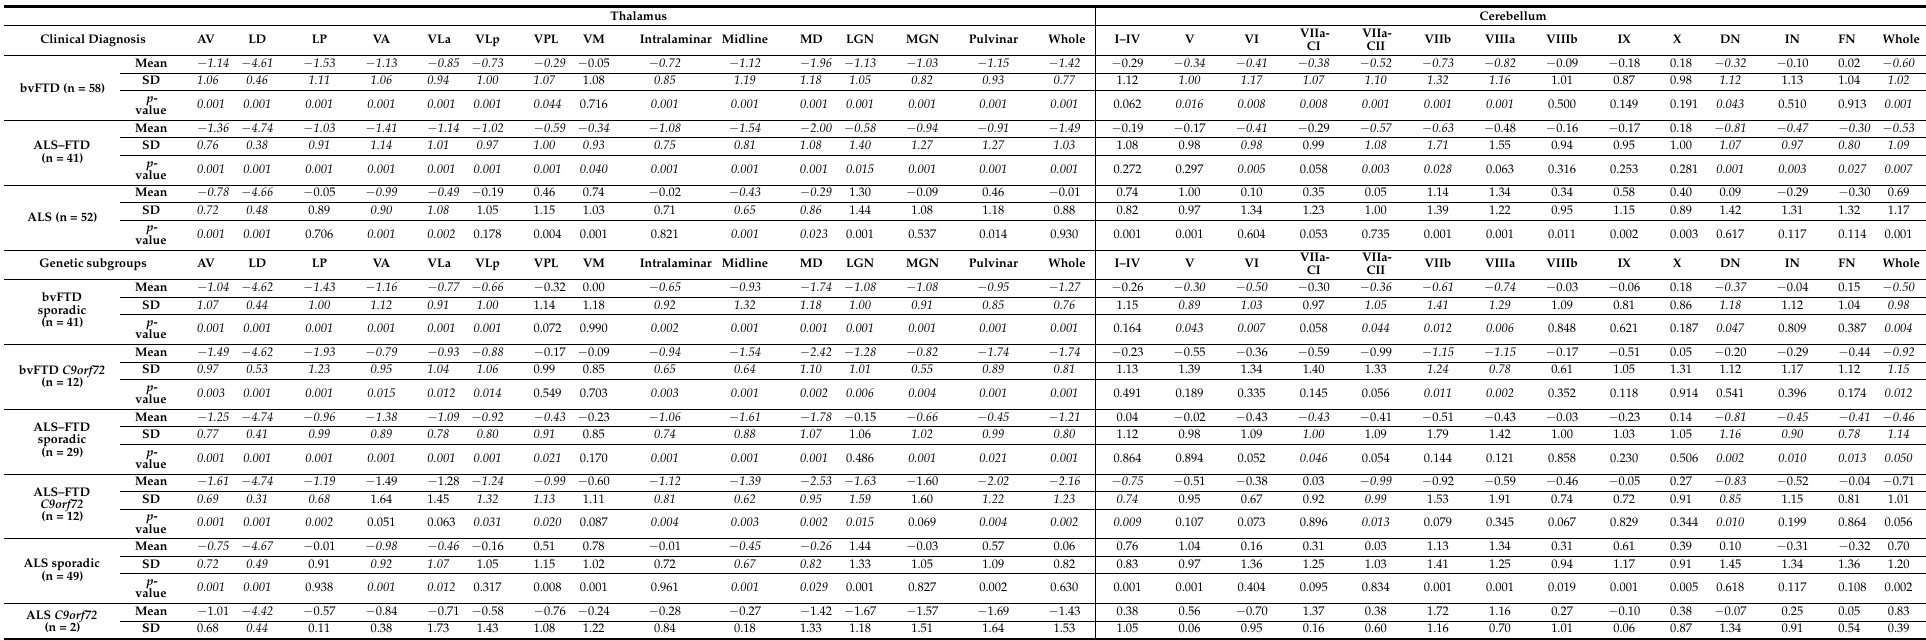
Table 2. Thalamic and cerebellar regions for the clinical and genetic groups. Values denote mean and standard deviation (SD) for the w-scores. Italics